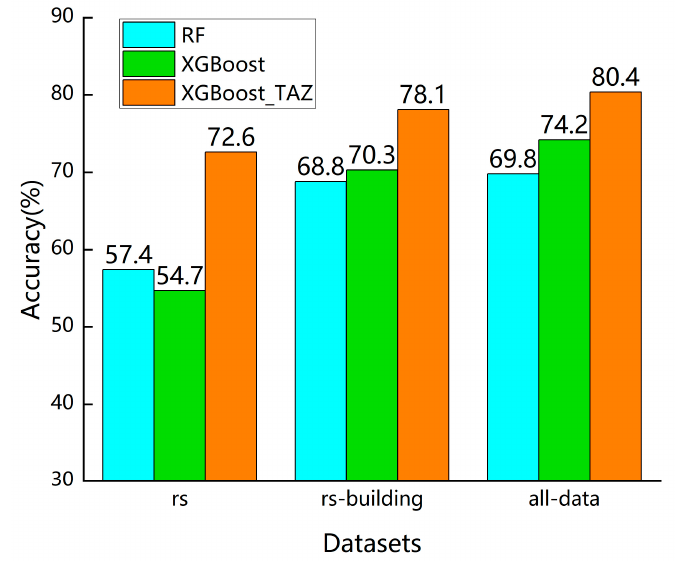
Figure 8. Classification accuracy of XGBoost and RF on different feature sets.